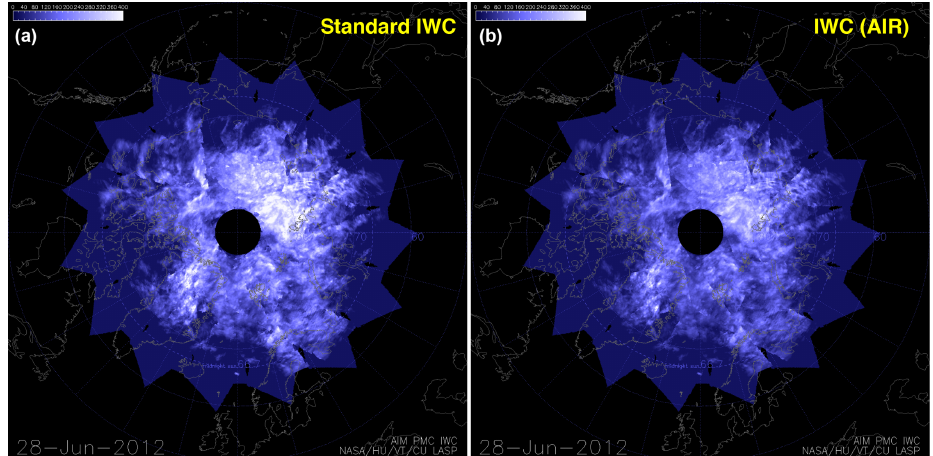
Figure 6. Polar projection map of IWC from CIPS, day 180 (28 June 2012). Panels (a) and (b) show the operational IWC product and the AIR result,